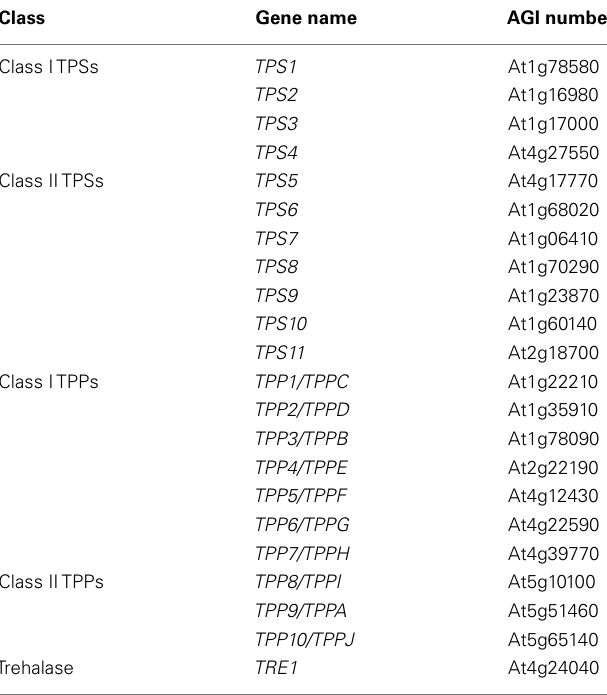
Table 1 | Genes involved in trehalose metabolism in Arabidopsis thaliana